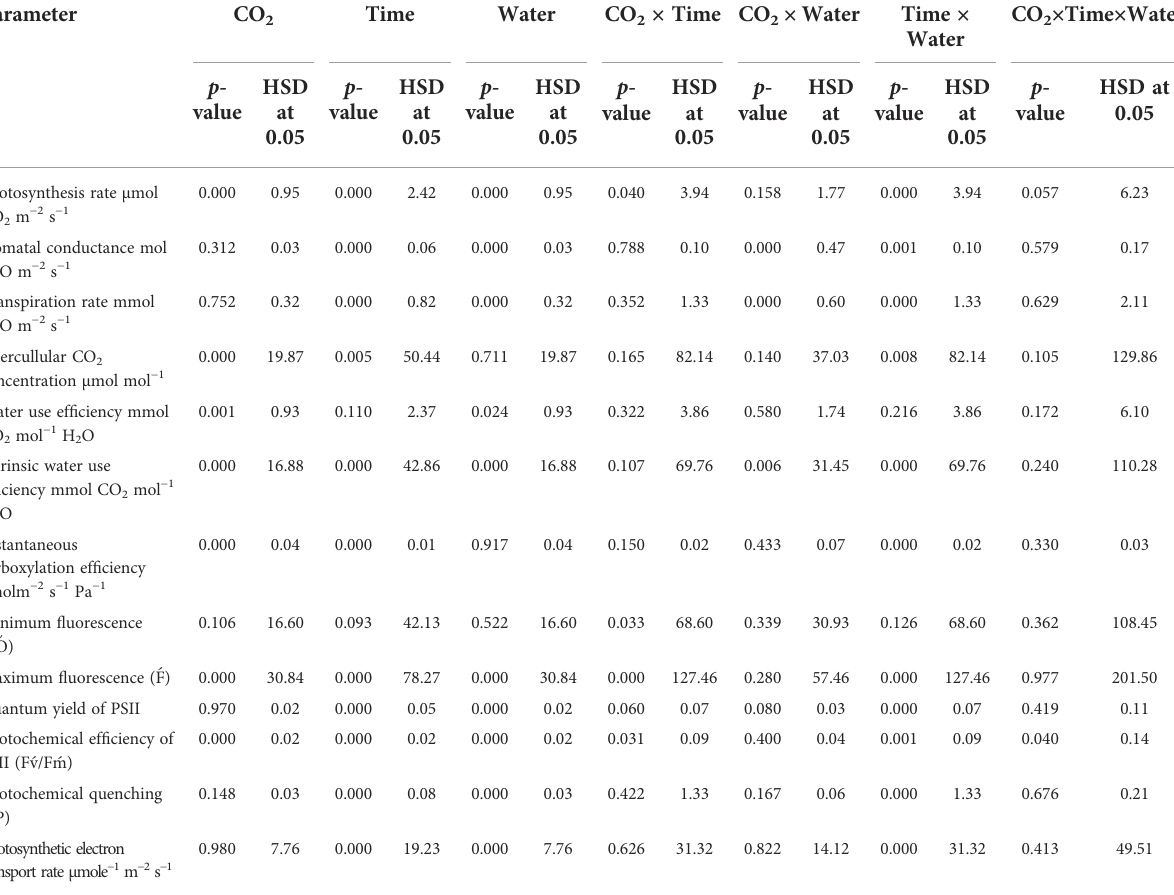
TABLE 1 Summary of the analysis variance for physiological parameters of Datura stramonium in response to CO 2 levels, water condition and time of observation.